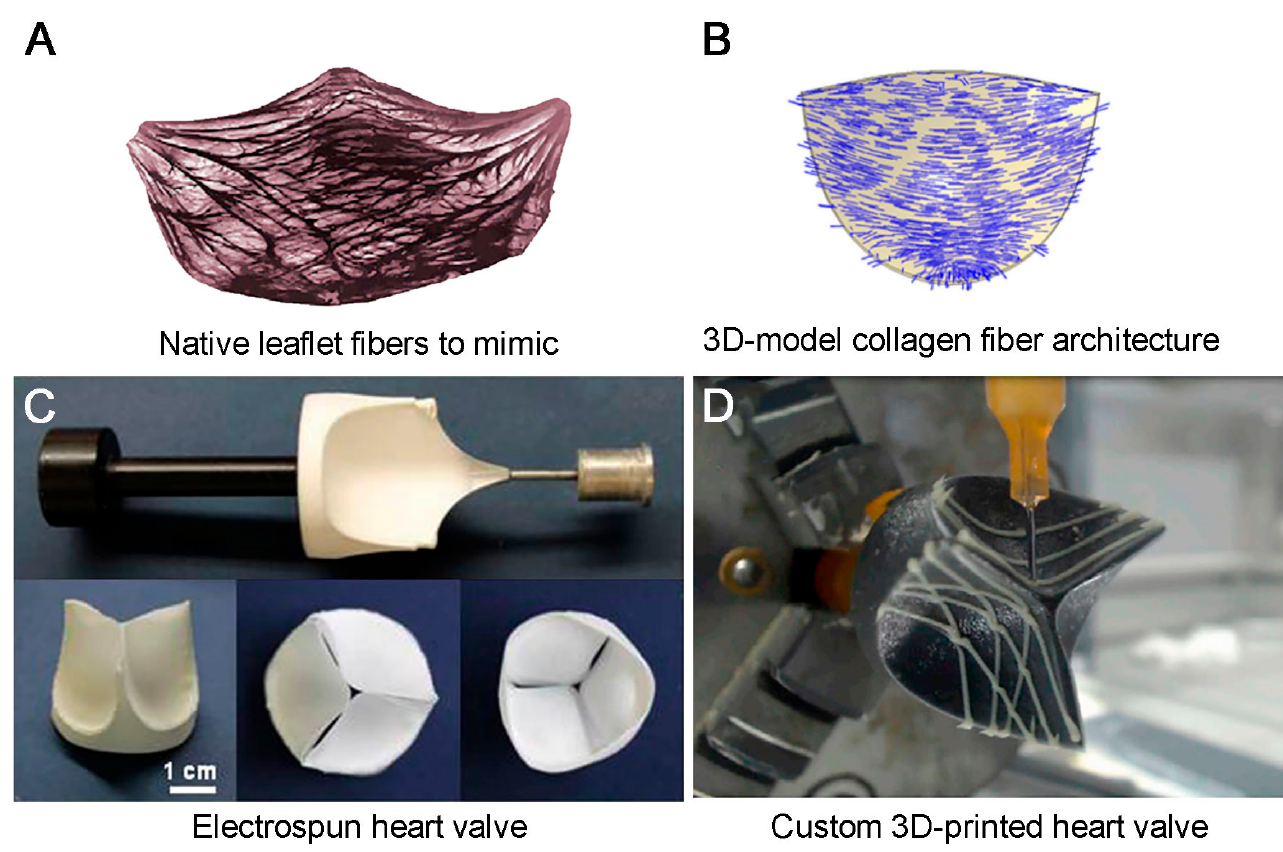
Figure 4. Orientation of collagen fibers in the native leaflets ( A ) (Coulter, 2019); fiber orientation modeling in numerical modeling ( B ) (Serrani, 2016); prototyping and electrospinning of a polymeric heart valve ( C ) (D’Amore, 2018); prototyping of a leaflet using a modified 3D printing system ( D ) (Coulter, 2019).